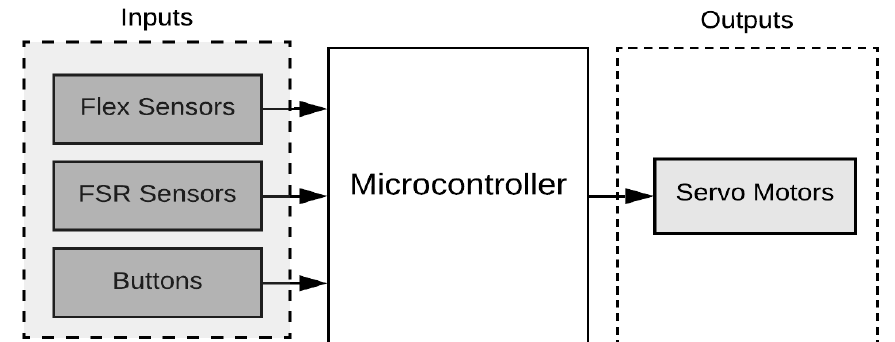
Figure 1. Block diagram of the system. Figure 1 . Block diagram of the system . Figure 1 . Block diagram of the system .